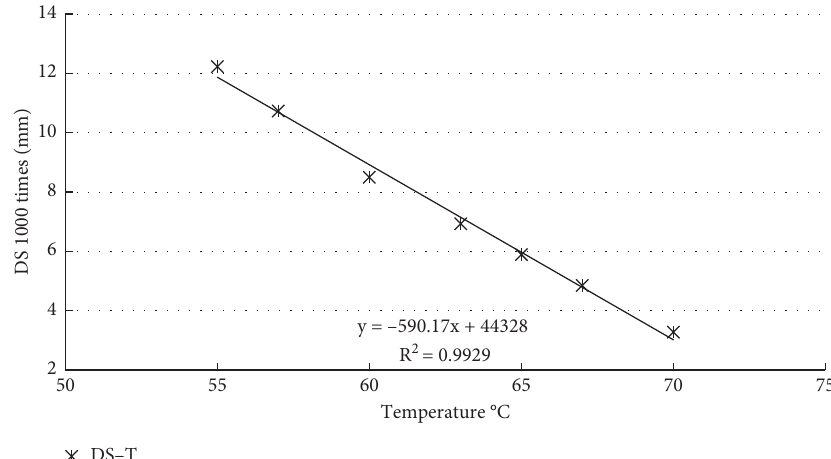
Figure 1: Relationship between DS and experimental temperature.